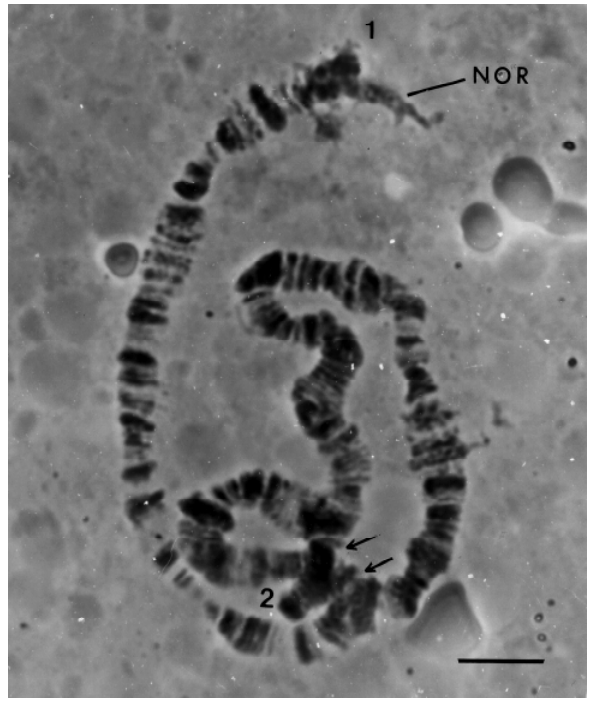
Figure 3 - X-chromosome of a salivary gland cell from a female larva of B. matogrossensis . Note the folding of the chromosome due to repeats (ar- rows) (a common finding in sciarid polytene X-chromosomes; see Perondini and Dessen, 1985), the nucleolus organizing region (NOR) and pairing of the homologs along the entire length of the chromosome. 1 and 2 denote the extremities of the chromosome. Bar = 10